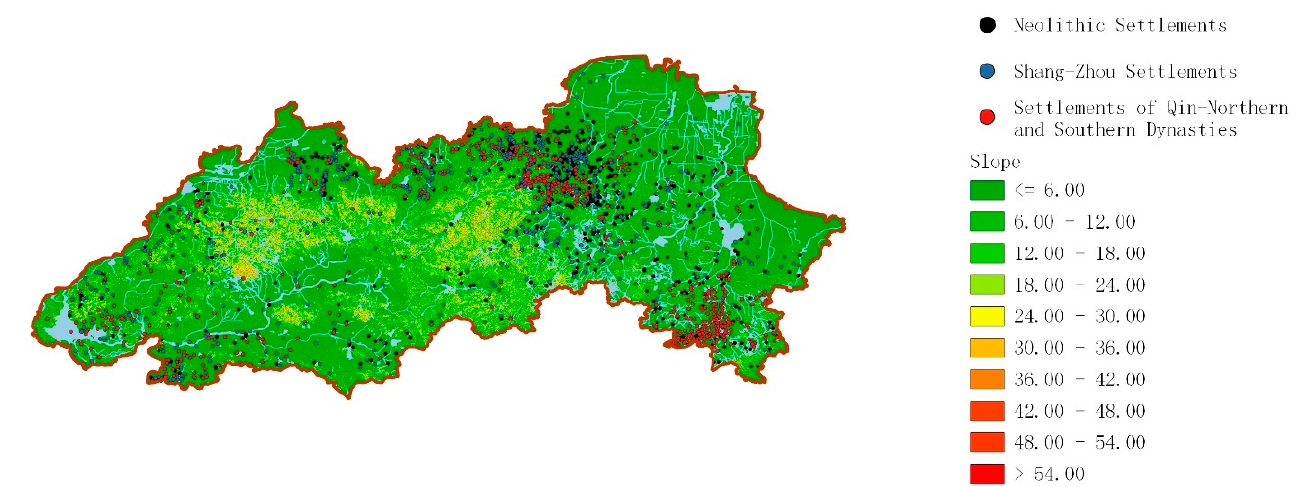
Figure 5. Elevation distribution of settlements in different periods.